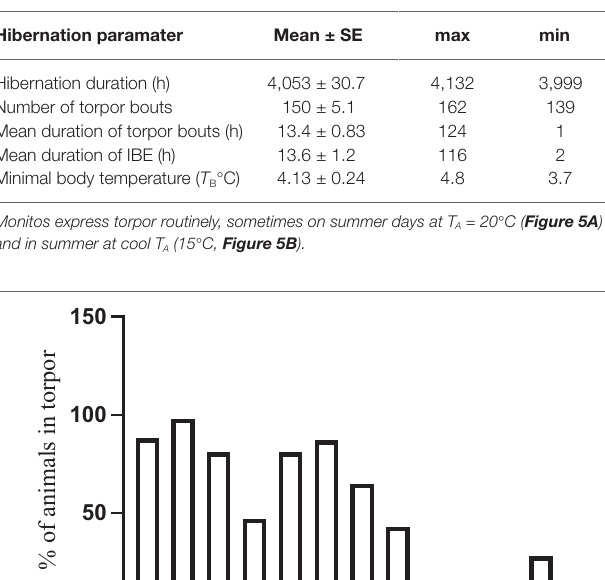
TABLE 1 | Hibernation parameters (mean ± SE) of monito del monte ( Dromiciops gliroides ) obtained in this study under natural conditions ( n = 4; this excludes the ramp